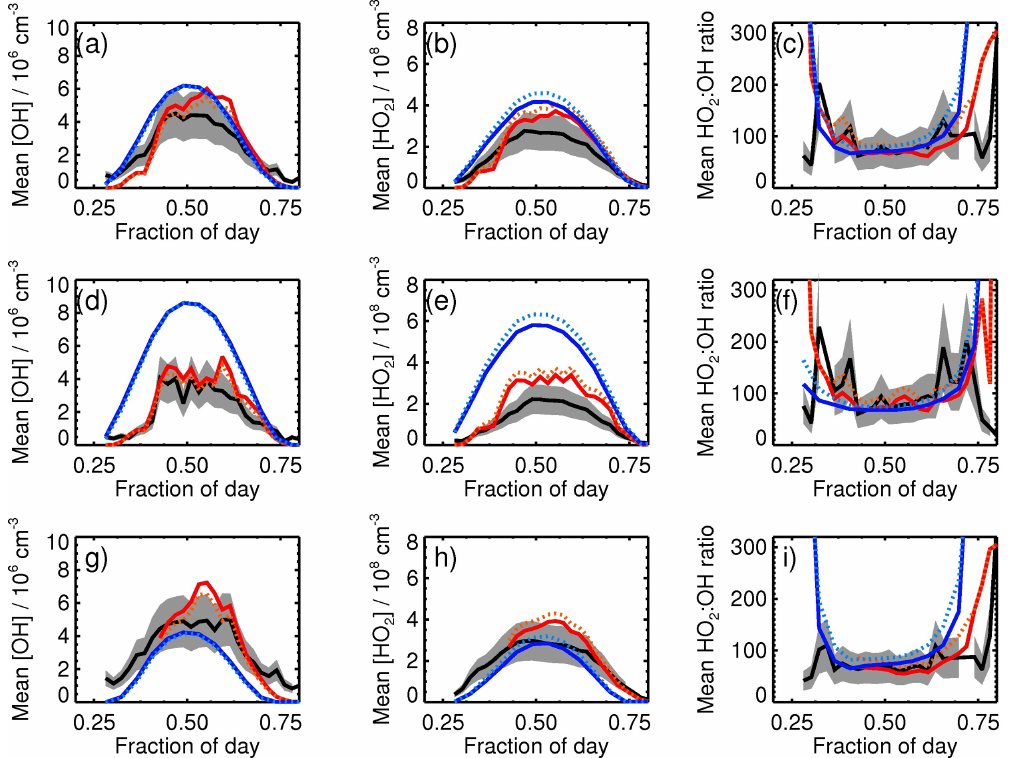
Figure 3. Average diurnal profiles during the Seasonal Oxidant Study (SOS) at the Cape Verde Atmospheric Observatory for (a) OH during both measurement periods; (b) HO 2 during both measurement periods; (c) HO 2 :OH ratio during both measurement periods; (d) OH during SOS1 (February–March 2009); (e) HO 2 during SOS1; (f) HO 2 :OH during SOS1; (g) OH during SOS2 (May–June); (h) HO 2 during SOS2; (i) HO 2 :OH ratio during SOS2. Observed data are shown in black, with grey shading indicating the variability in the observations; box model output with halogen chemistry is shown by solid red lines; box model output without halogen chemistry is shown by broken orange lines; global model output with halogen chemistry is shown by solid dark blue lines; global model output without halogen chemistry is shown by broken blue